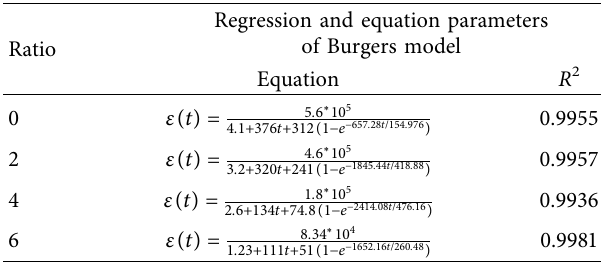
Table 6: Regression analysis of relaxation for SBS modifier asphalt with different WEOB content in Burgers model.